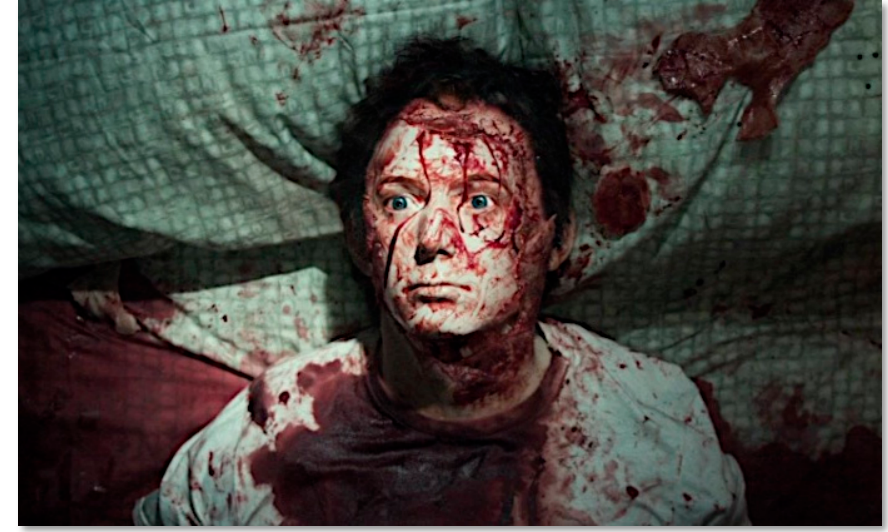
Figure 19. Image from Maniac (2012) [48].